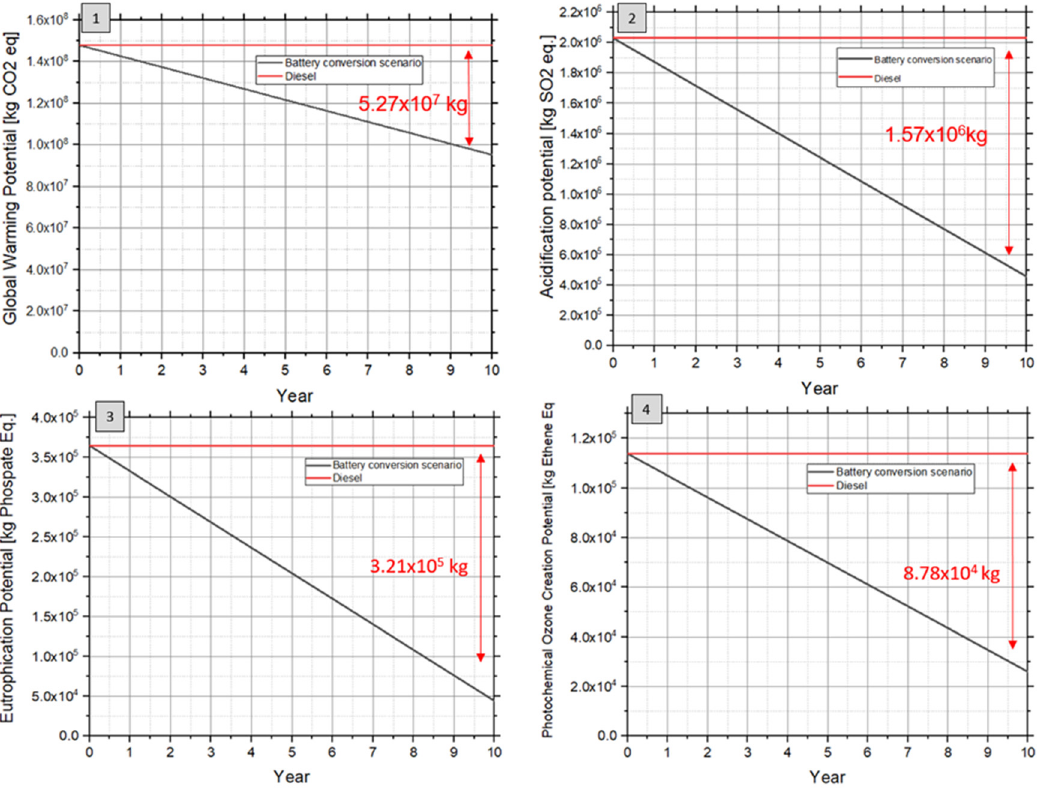
Figure 15. LCA results with battery conversion scenario for 140 ships over ten years; ( 1 ) GWP, ( 2 ) AP, ( 3 ) EP, ( 4 ) POCP.